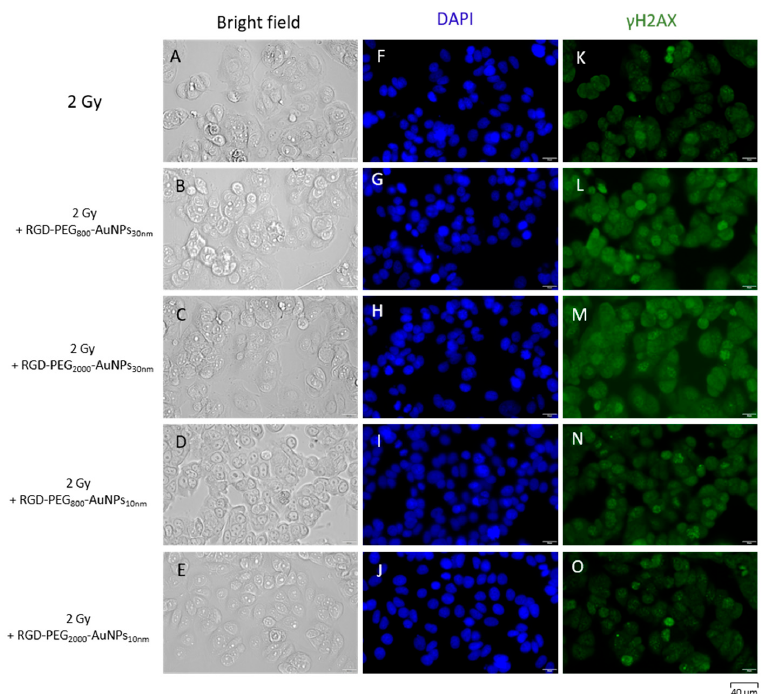
Figure 10. The immunofluorescence of γ H2AX after cell exposure to 2 Gy and dose of 2 Gy with the previous 50 min incubation with AuNPs in the 2D model. The morphology of cells was presented in the bright field ( A – E ). The nuclei of cells were dyed with the DAPI solution ( F – J ). The γ H2AX foci were dyed using the solution in green (488 nm) ( K – O ).